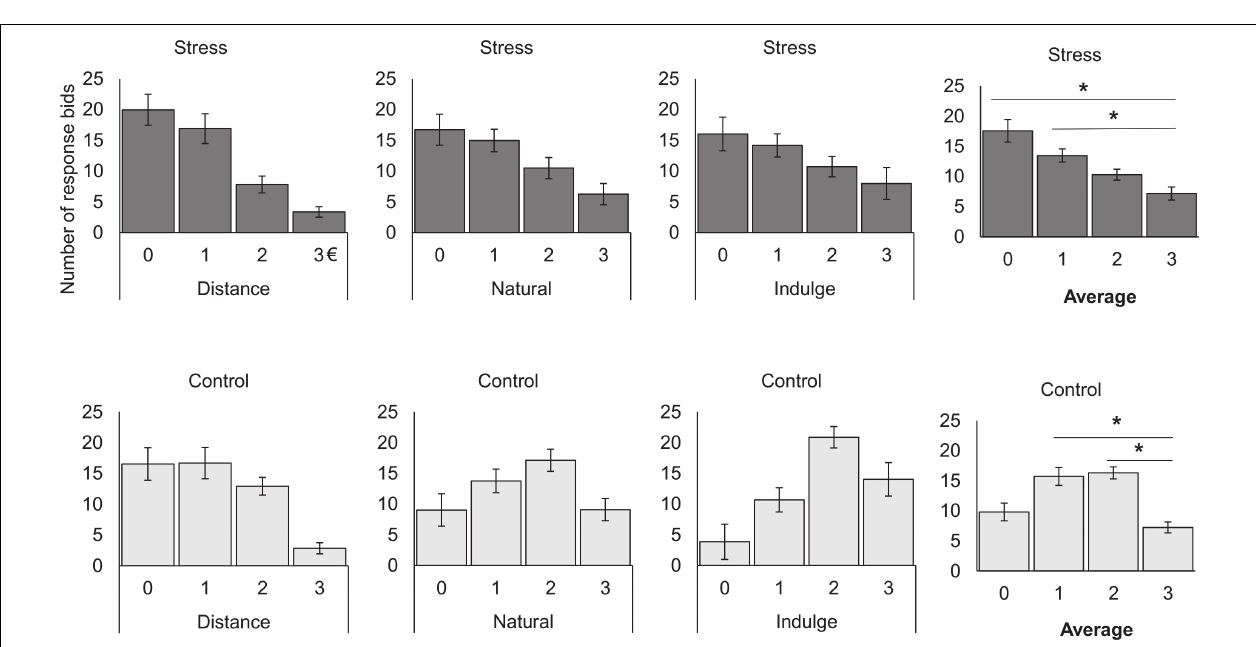
FIGURE 3 | Representation of the normalized rating scores for food pictures for each trial condition (natural, distance, and indulge) before performing the functional magnetic resonance task (before cognitive regulation) and during the functional magnetic resonance task (after cognitive regulation) for the stress and control groups (the normalized scores represent the ratio between given score and maximum score). Before cognitive regulation, we did not find statistically significant differences between groups or within group in terms of food valuation across the conditions. After cognitive regulation, the stress group had lower average valuation scores in comparison to the control group [group F ( 1 , 25 ) = 6.91, p = 0.014, χ 2 = 0.22]. The black star represents statistically significant differences. The main bars represent the mean values and the error bars represent the standard error.